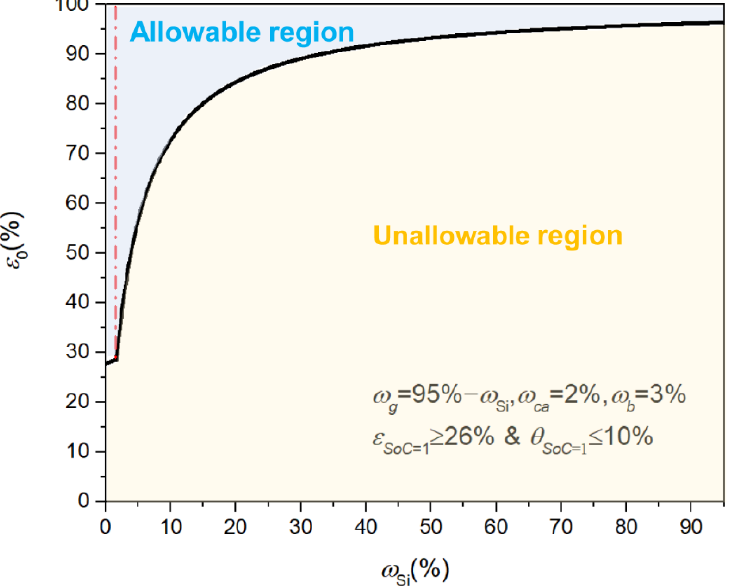
Figure 6. The design space of the initial porosity and the mass fraction of the Si component based on the limits of maximum volume change and minimum porosity for Si-based composite electrodes at SoC = 1.